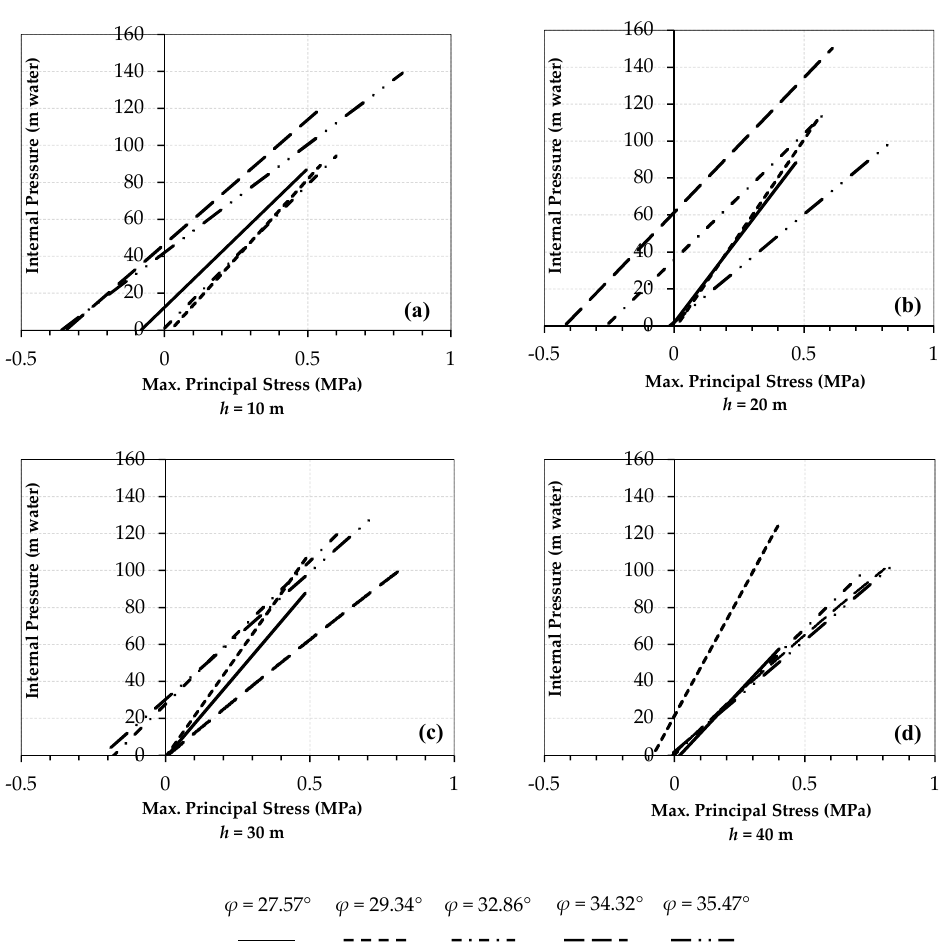
Figure 9. Effect of overburden height on the bearing capacity of the tunnel. ( a ) h = 10 m; ( b ) h = 20 m; ( c ) h = 30 m; ( d ) h = 40 m.